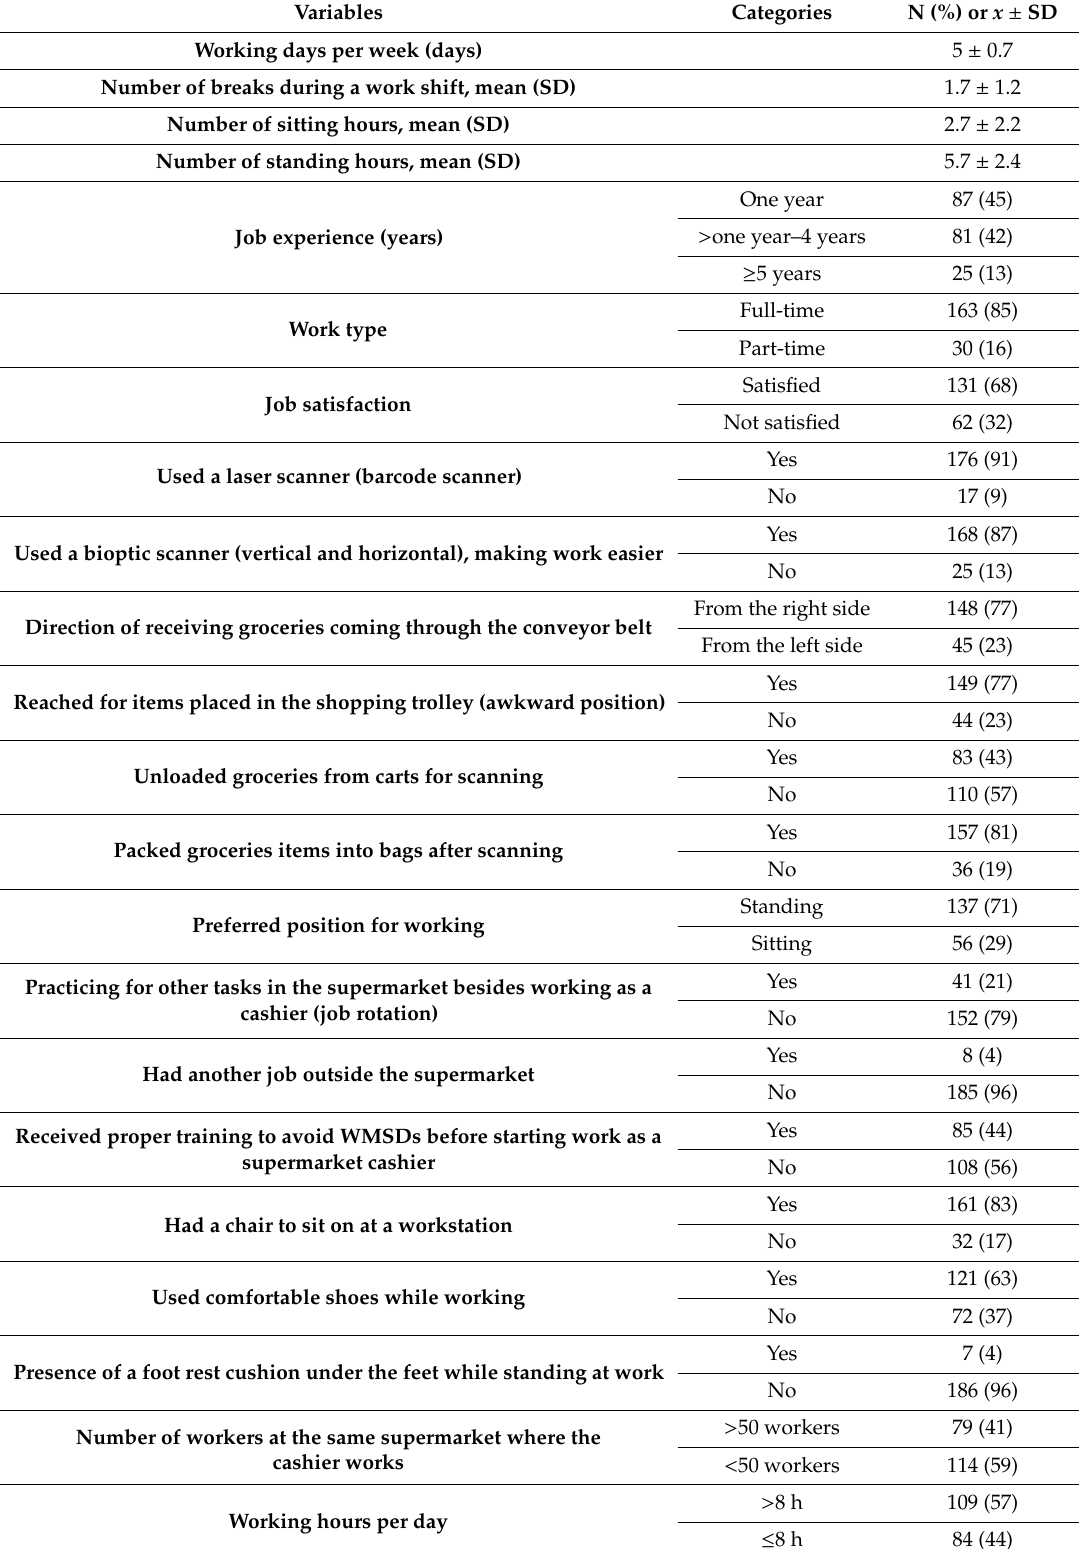
Table 2. Summary statistics of occupation-related